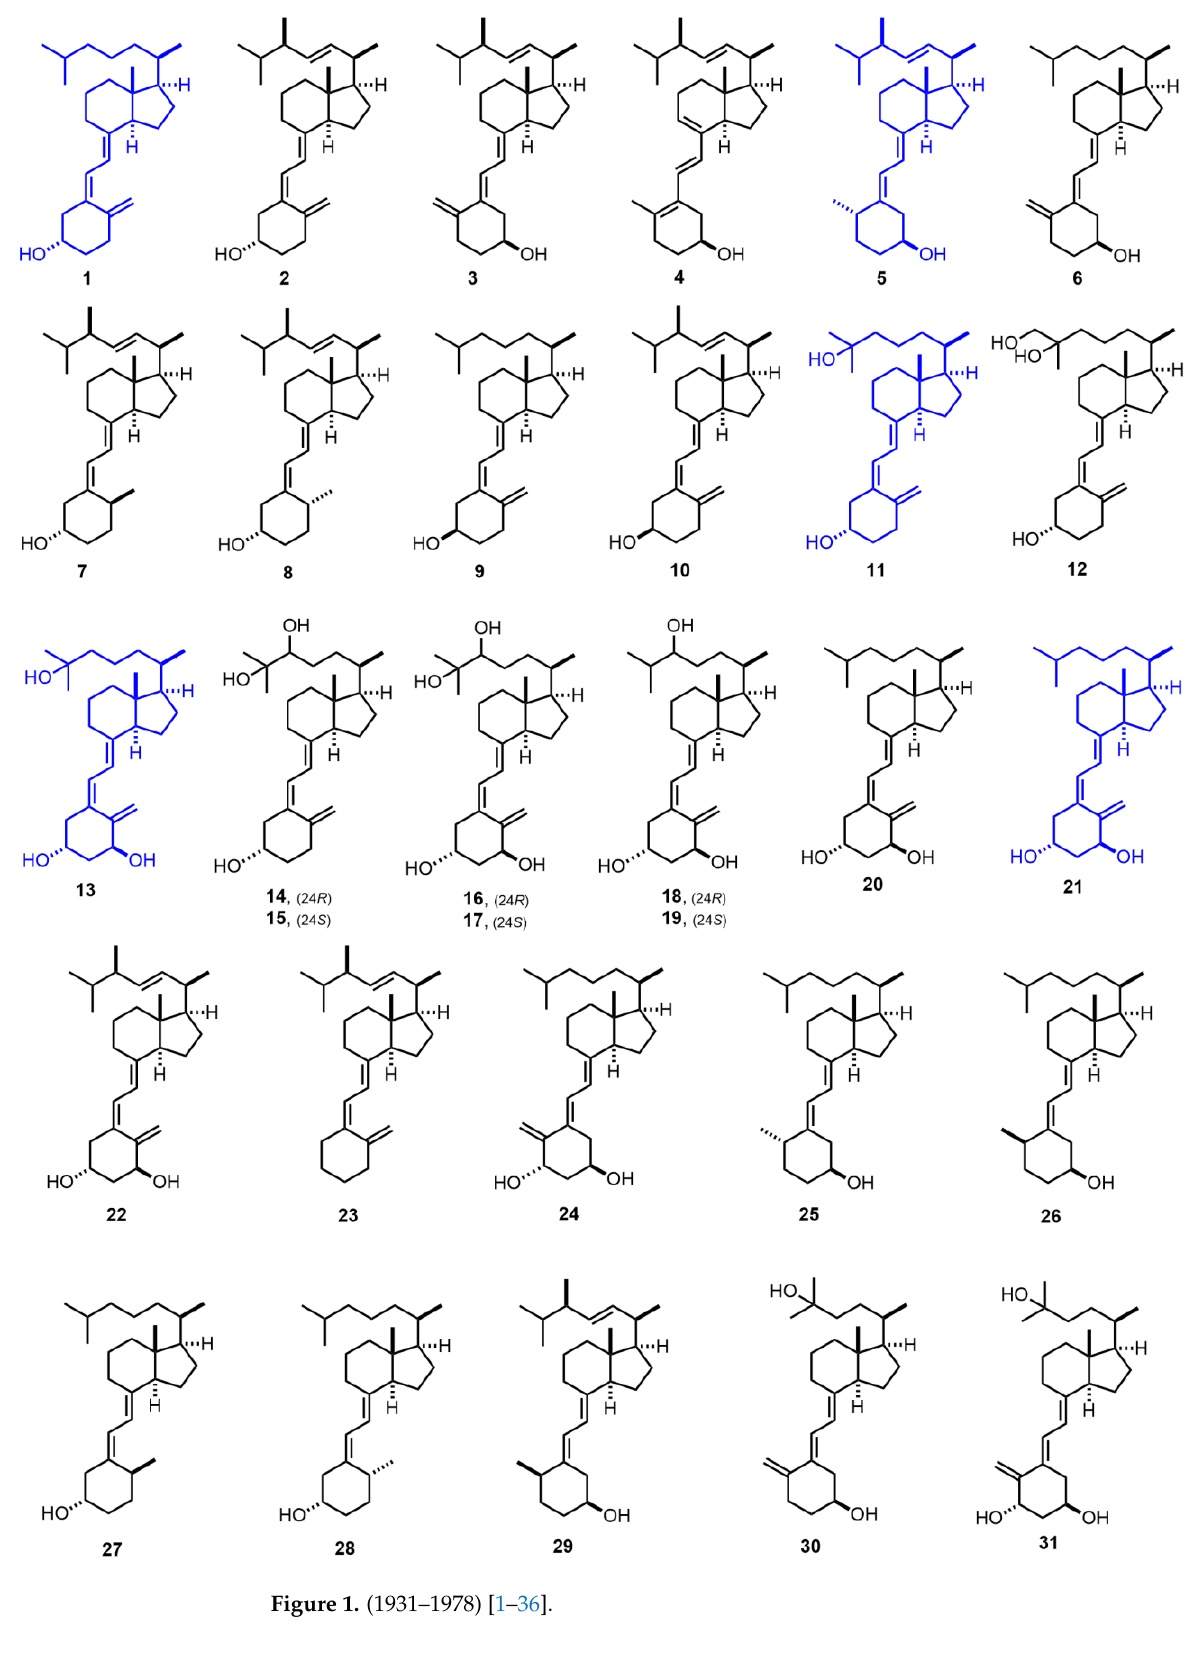
Figure 1. (1931–1978)